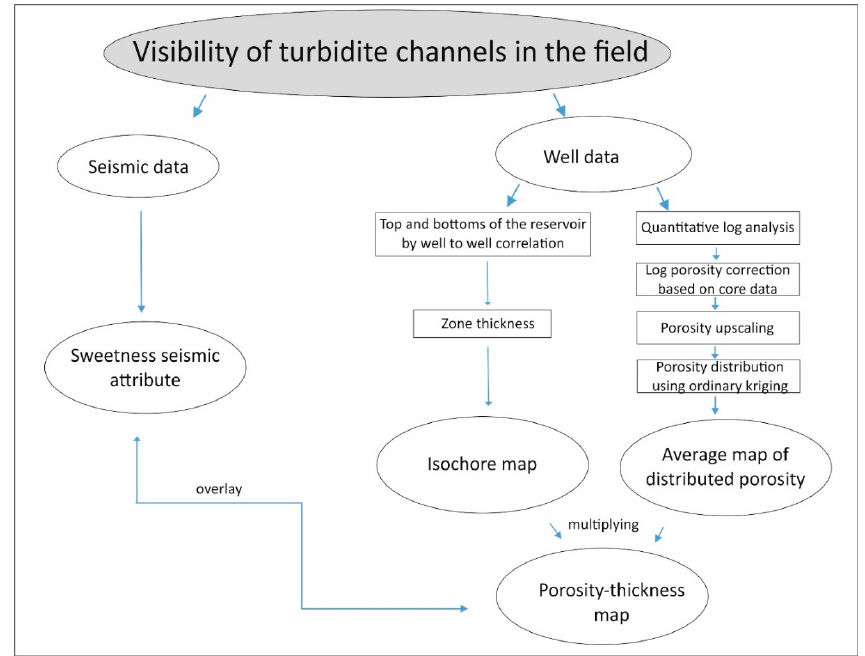
Figure 4. Flowchart of applied methodology.